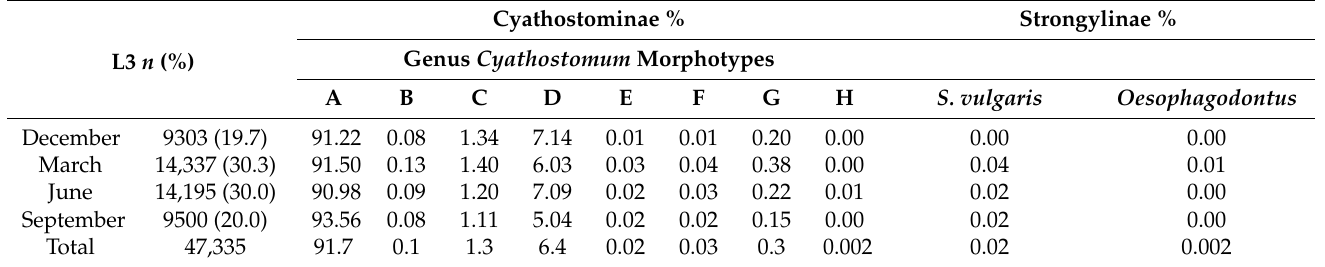
Table 6. Abundance of strongylid third-stage larvae per month over the study